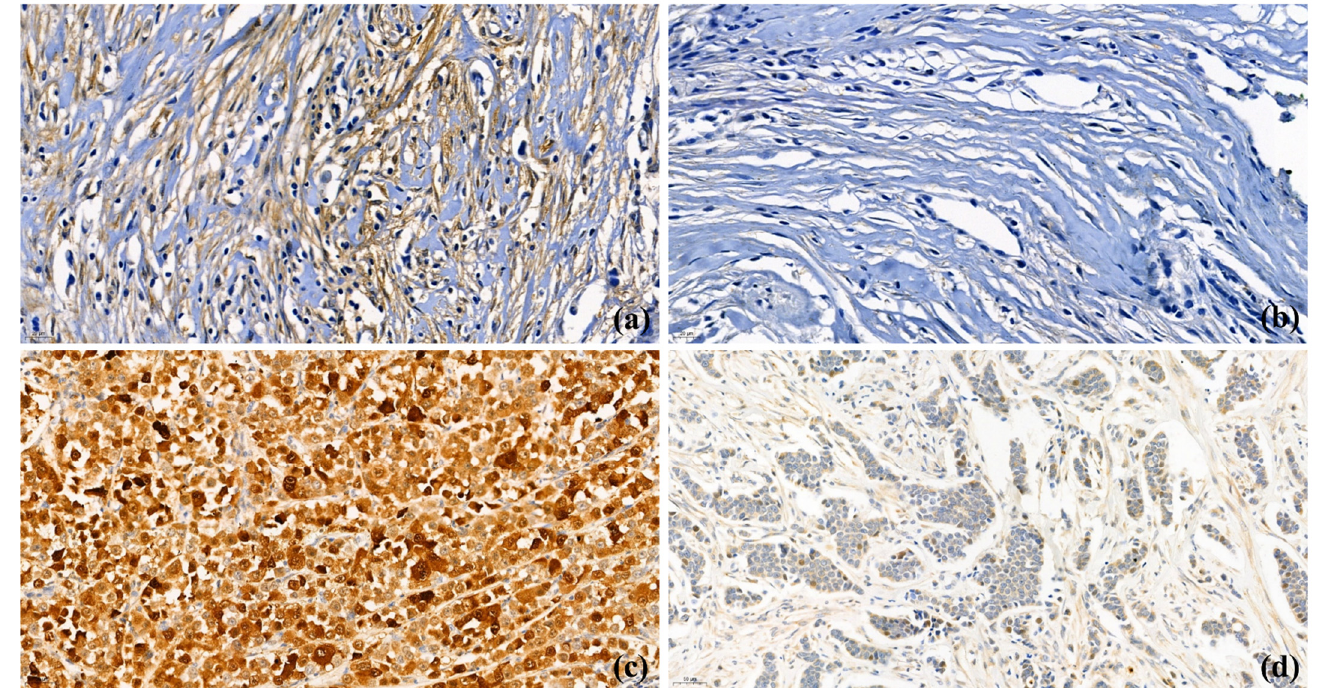
Figure 1. BAG2 expression in cancer-associated fibroblasts (CAFs) and cancer cells (400 × magnification); ( a ) BAG2-positive CAFs in stroma; ( b ) BAG2-negative CAFs in stroma; ( c ) BAG2-high expression in the cytoplasm of primary breast cancer cells; ( d ) BAG2-low expression in the cytoplasm of primary breast cancer cells.